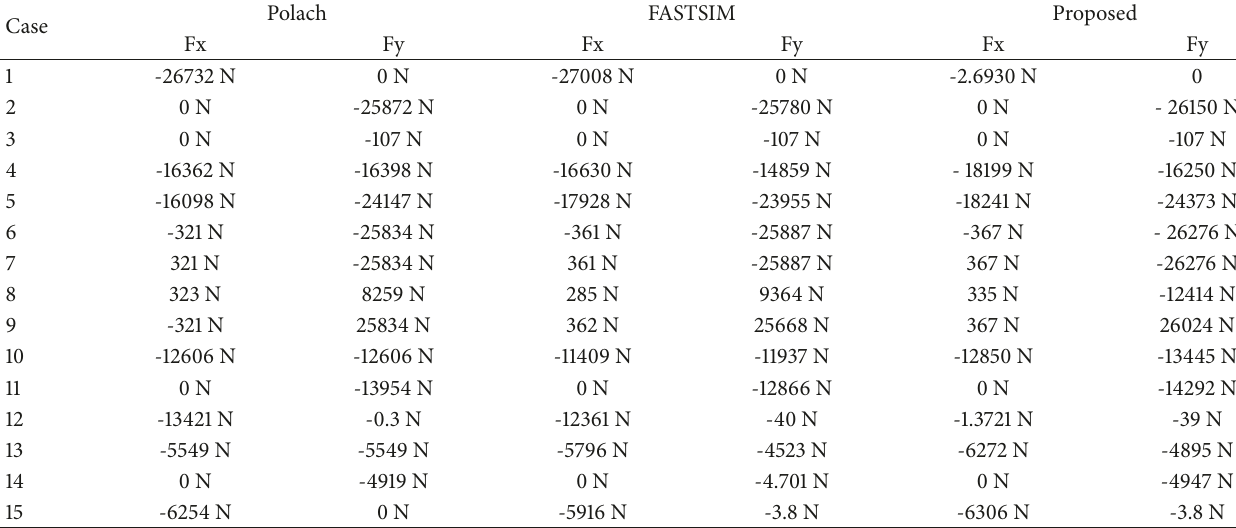
Table 5: Results of the comparison in terms of tangential forces.